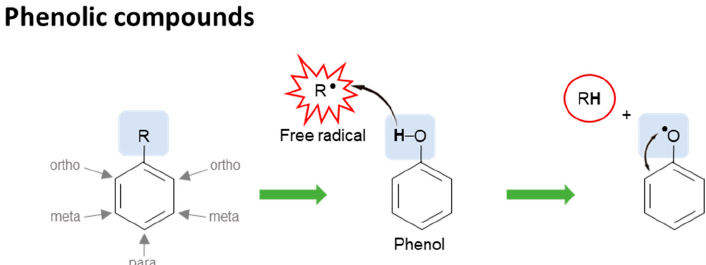
Figure 2. Antioxidants (phenolic compounds) in rice and structure-activity relationship. Phenolic compounds act as free radical scavengers since hydroxyl group on the phenolic ring can transfer its hydrogen atom to a free radical, forming a delocalized and stabilized unpaired electron, phenoxy radical, across the phenolic ring. The antioxidant capacity of phenolic compounds is in function of the numbers of hydroxyl groups, the location of hydroxyl group on aromatic ring ( ortho , para , meta positions), and the presence of other functional groups on the